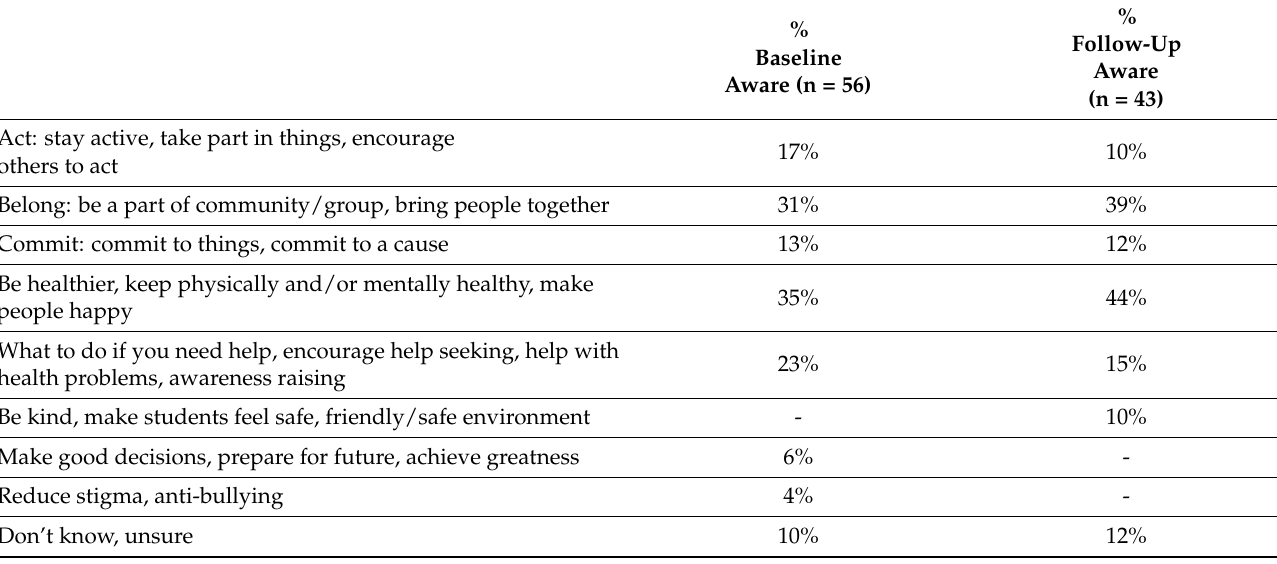
Table 2. Students’ understanding of the Act–Belong–Commit campaign *.